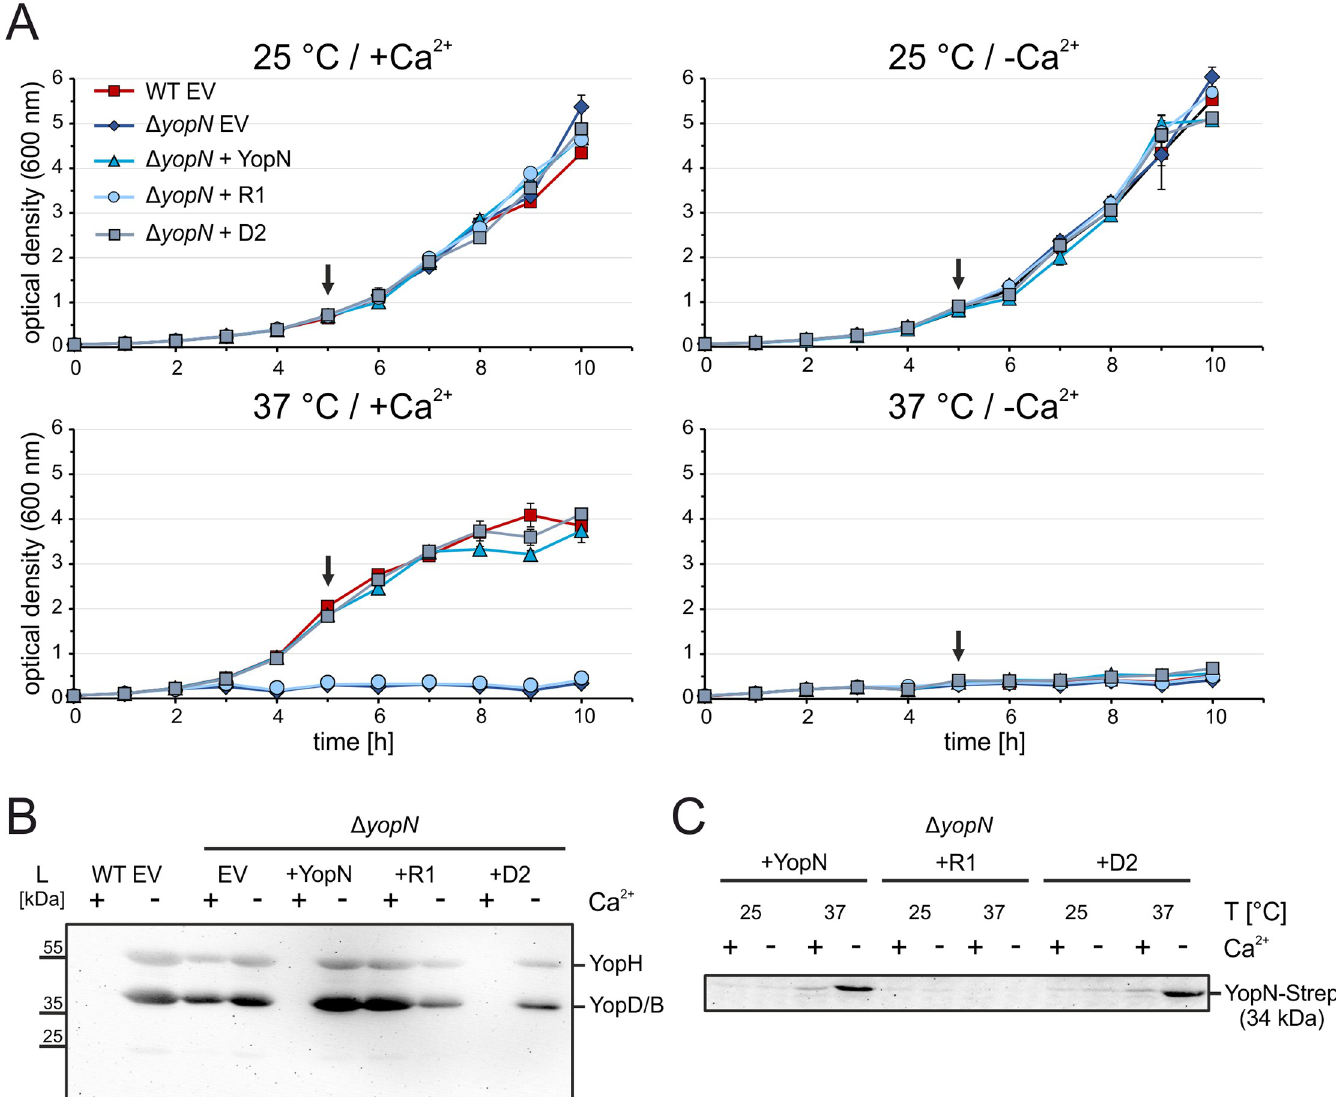
Fig 7. The closed RNAT variant R1 is unable to rescue the temperature-sensitive phenotype of the Δ yopN mutant. (A) Growth experiment of Y . pseudotuberculosis YPIII wild type (WT) and Δ yopN with the empty vector pGM930 (EV) and Δ yopN with vectors containing arabinose-inducible constructs of yopN with the wild type RNAT, the stable variant R1 or the open variant D2. The growth experiment was performed in triplicate. The strains were incubated in secretion-induced (-Ca 2+ ) and secretion-noninduced (+Ca 2+ ) LB medium at 25 and 37˚C. Growth was measured by optical density at 600 nm. (B) Visualization of secreted effector proteins by SDS-PAGE using Coomassie blue staining and Western blotting using total-anti-Yop serum. Samples were taken after five hours at 37˚C (black arrows) and secreted proteins were TCA-precipitated from filtered supernatants. (C) Production of YopN-Strep was visualized by Western blotting using Strep-tag antibody. Samples were taken as described for (B) and protein levels were adjusted to an optical density of